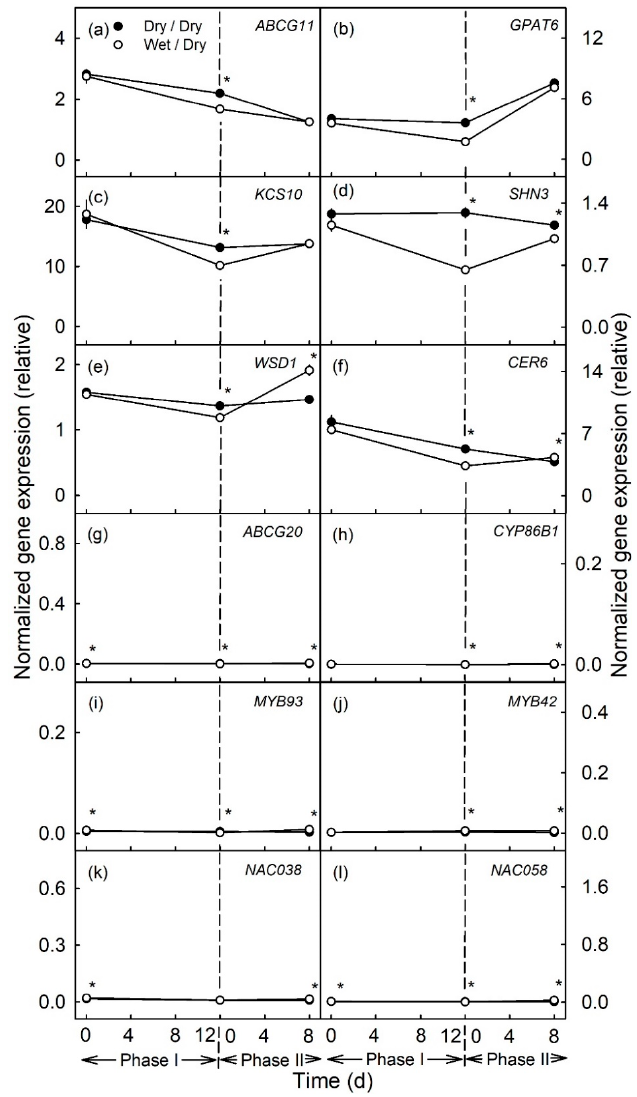
Figure 3. Time course of expression of genes related to cutin and wax synthesis ( a – f ) and to suberin and lignin synthesis ( g – l ) of apple fruit skin during moisture exposure (Phase I) and after exposure to moisture was discontinued (Phase II). During Phase I, a patch of the fruit skin was exposed to moisture for 12 d beginning at 66 days after full bloom (DAFB) (wet). During the subsequent Phase II, moisture was removed, and the patch was exposed to the atmosphere (dry). Moisture-exposed patches of the fruit skin are referred to as wet/dry, unexposed control patches as dry/dry. The end of moisture exposure is indicated by the vertical dashed line. The expression values are means ± SE of three to five independent biological replicates comprising ten fruit each. The ‘*’ indicates significant differences between dry/dry and wet/dry at p ≤ 0.05 (Student’s t -test).